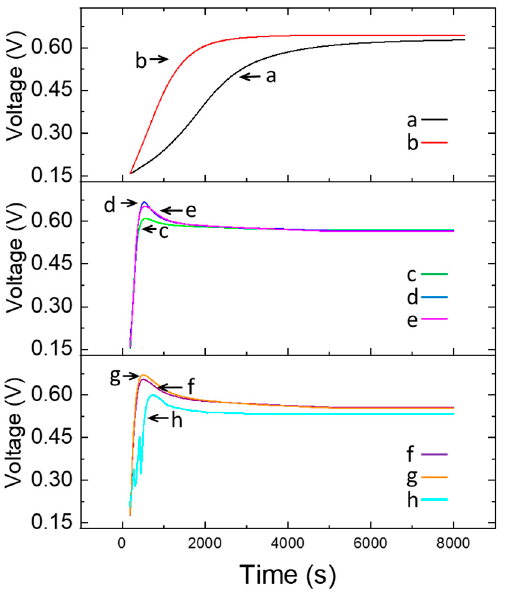
Figure 5. Di ff erences in the response of the fuel cell, fed with 2.50% ethanol hydroalcoholic solution: ( a ) as such, ( b ) modi fi ed with LDHs, i.e., ZnAl-NO 3 (63 mg), inserted into the anodic section, ( c ) modi fi ed with LDH-catalase mixture (63 mg: 40 mg) inserted into the anodic section, ( d ) modi fi ed with LDH-catalase mixture (63 mg: 63 mg) inserted into the anodic section, and ( e ) modi fi ed with LDH-catalase mixture (63 mg: 92 mg) inserted into the anodic section. Furthermore, ( f – h ) measure- ments were carried out with fuel cell modi fi ed with LDH-catalase mixture (63 mg: 92 mg) but in the presence of di ff erent concentrations of hydrogen peroxide in solution, i.e., 4, 12, and 40 mmol L − 1 , respectively.